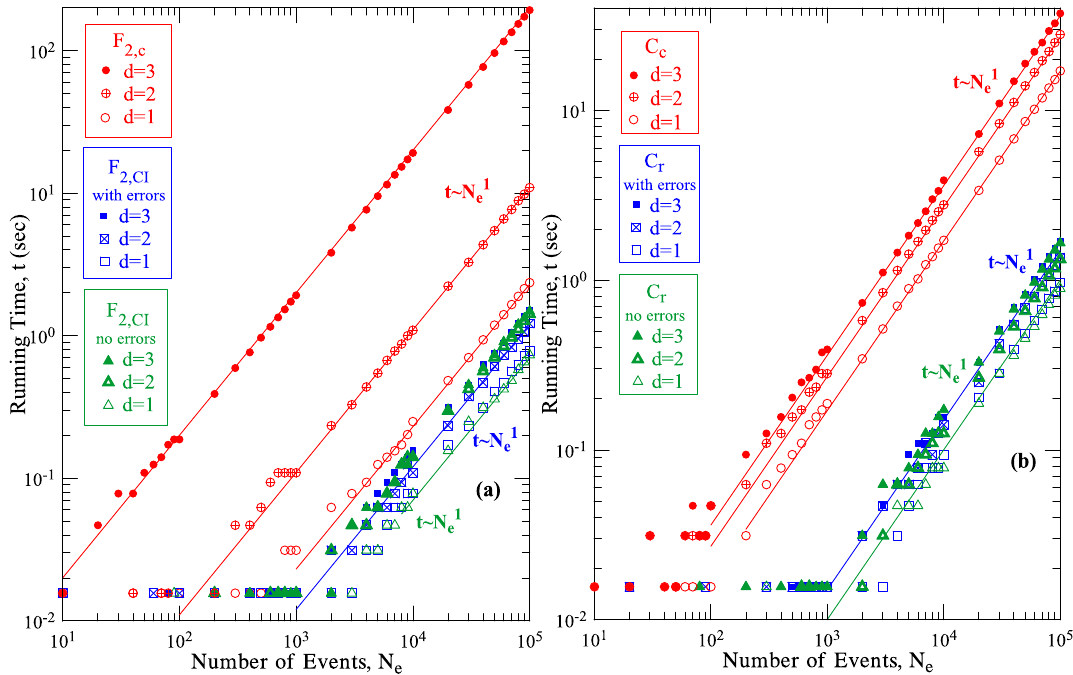
Fig. 4 The running time for F 2 in a and C in b and for different techniques as function of the number of events N e , for fixed estimation points N D = 30 and N m =